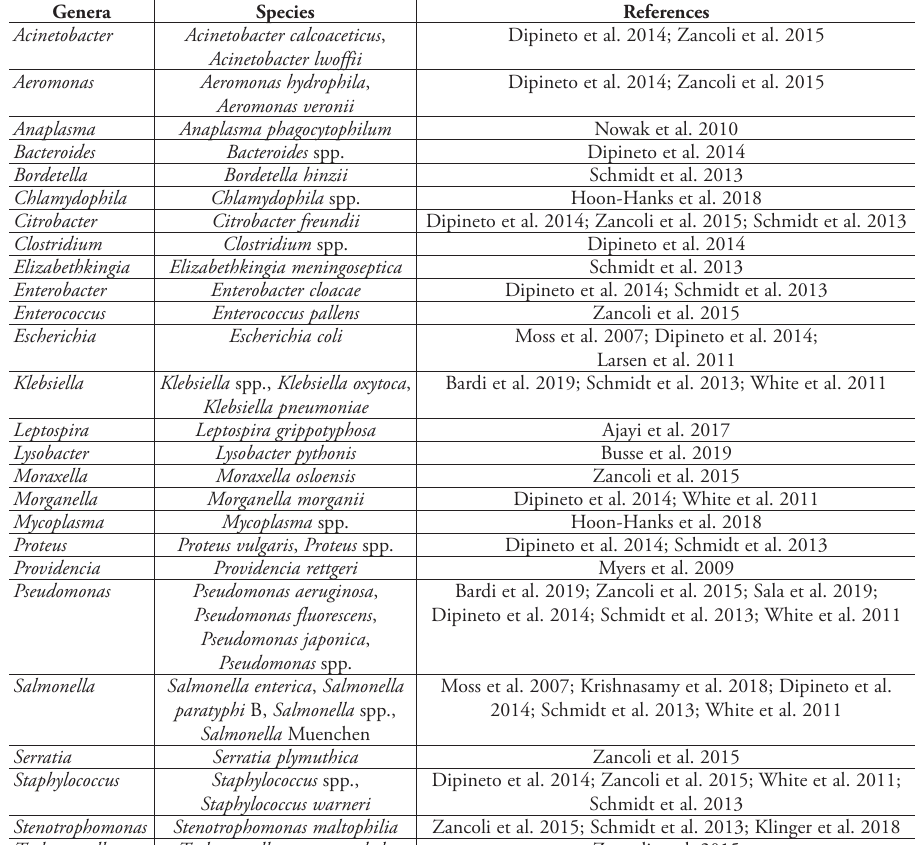
Table 1. List of potentially pathogenic bacteria from ball pythons ( Python regius ) (see